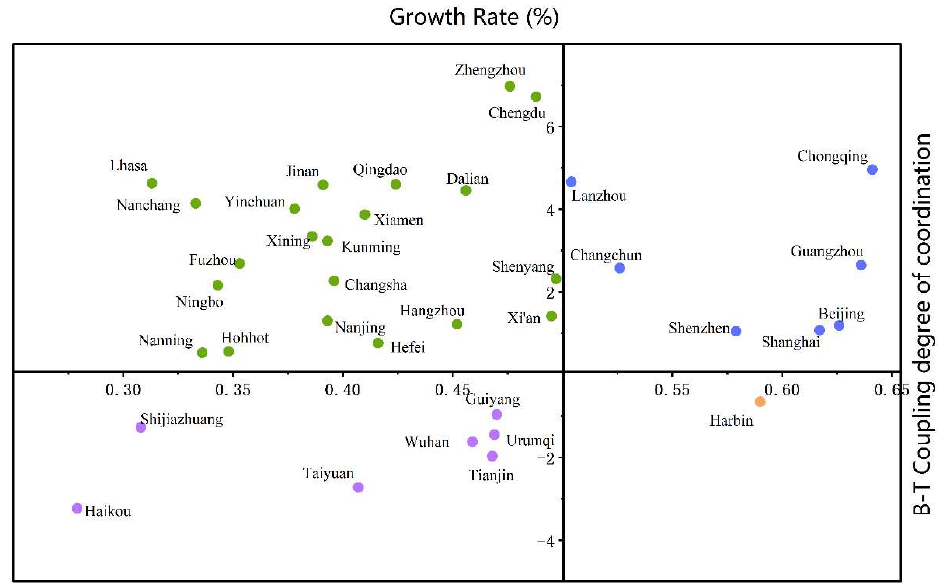
Figure 6. Coupling coordination relationship for B-T in 36 cities in China.